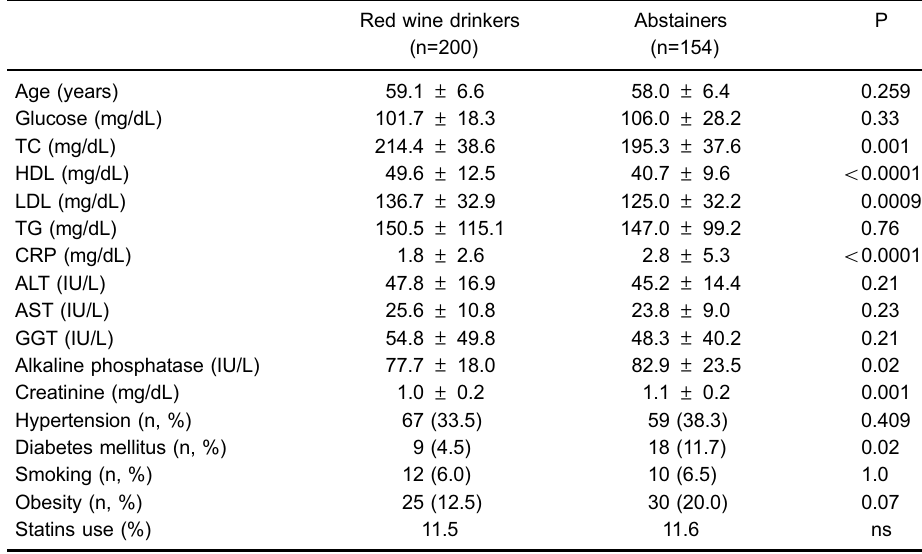
Table 1. Baseline clinical and laboratory